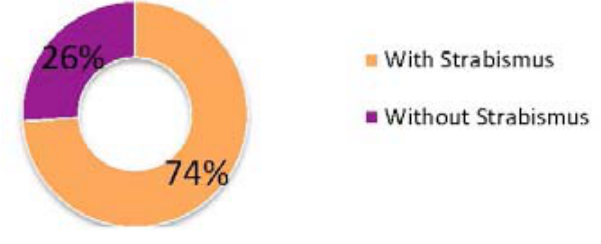
Figure 1: Prevalence of Strabismus Irrespective of the test used, of the 37 subjects who presented with a strabismus, either at distance, near or both, 24% ( n =9) had an esotropia and 76% ( n =28) were exotropic (see Figure 2).